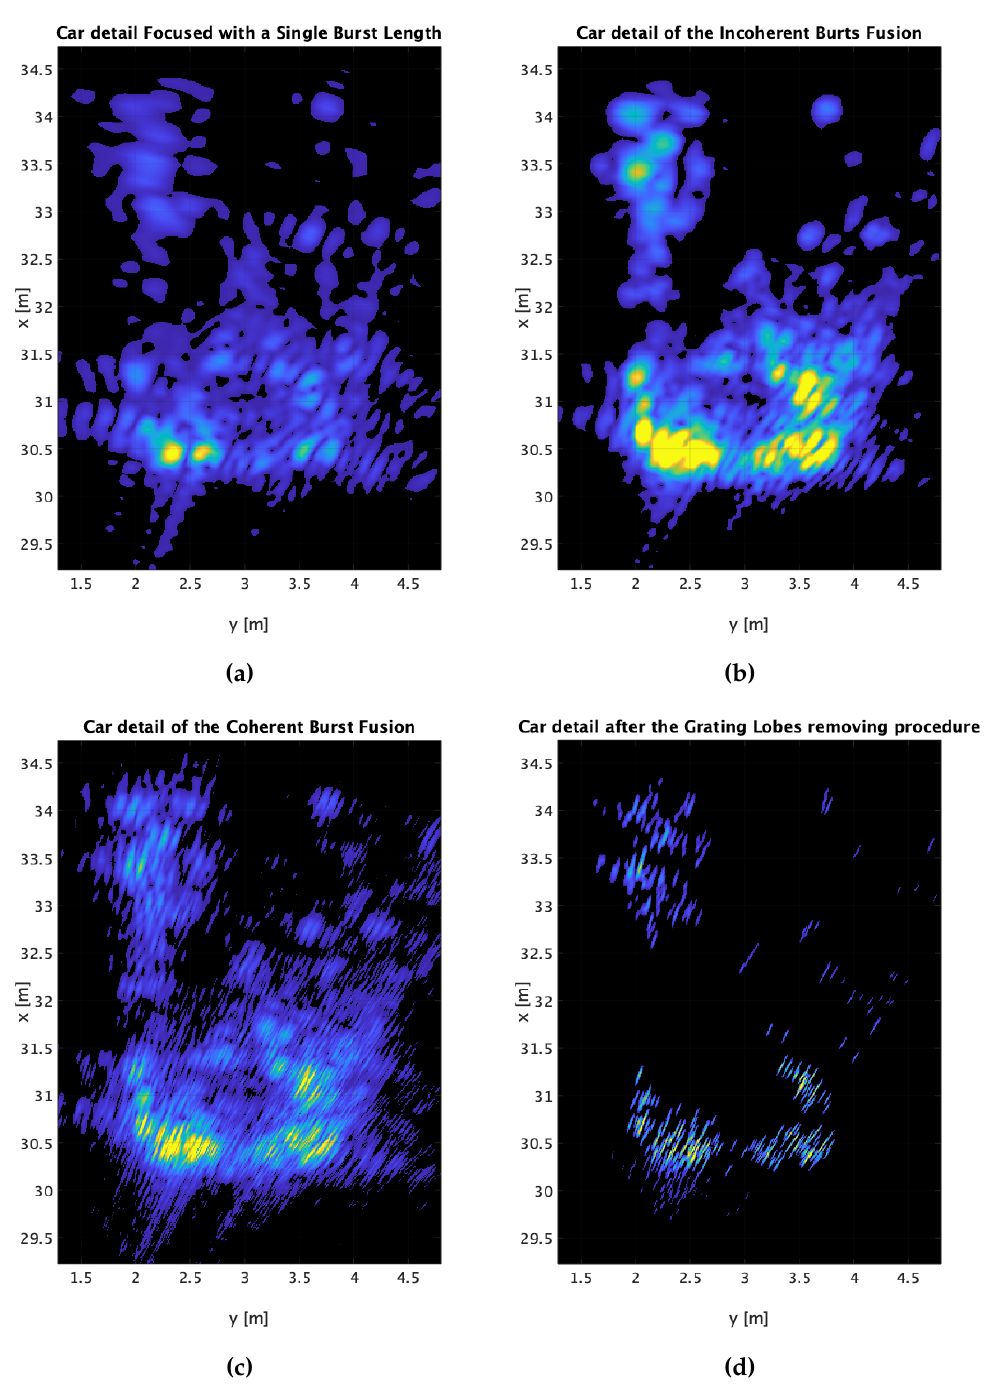
Figure 12. ( a ): Car detail of a SAR image generated using the synthetic aperture of a single burst length. ( b ): Car detail of a SAR image generated using the incoherent sum of the three bursts. ( c ): Car detail of a SAR image generated using the coherent sum of the three bursts. ( d ): Car detail of a SAR image generated using the grating lobes removing procedure.